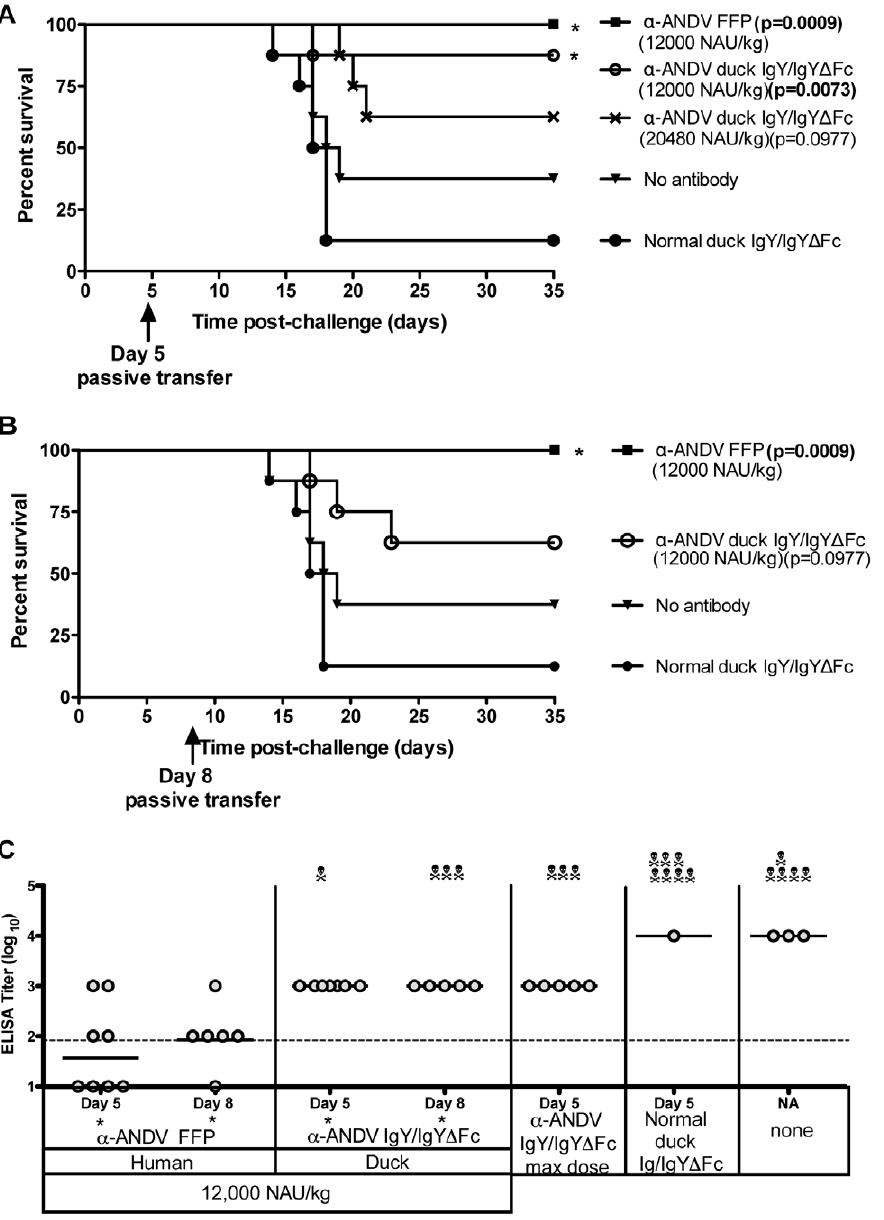
Figure 5. 12,000 NAU/kg of a -ANDV FFP and a -ANDV duck IgY/IgY D Fc protects hamsters from lethal HPS disease. A) and B) Survival curve of hamsters that were challenged with 4,000 PFU i.n. of ANDV on day 0 and passively transferred with a -ANDV FFP or a -ANDV duck IgY/IgY D Fc on day 5 postinfection (A) or day 8 postinfection (B). * indicates statistical significance when compared to normal IgY/IgY D Fc treatment. C) a -N ELISA endpoint titers (log 10 ) were conducted with sera from surviving hamsters challenged with ANDV in A) and B). GMT for each group are shown. * indicates results are statistically significant when compared to no antibody